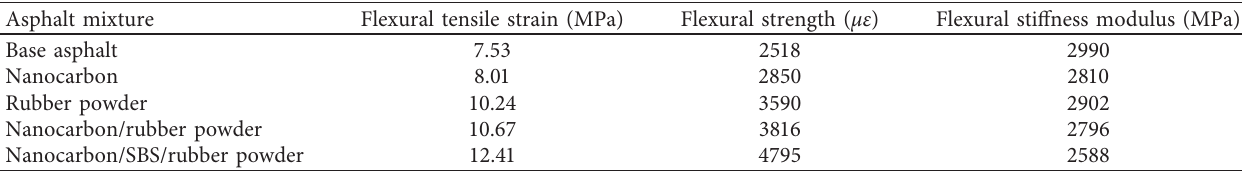
Table 9: Results of the low-temperature trabecular bending test.